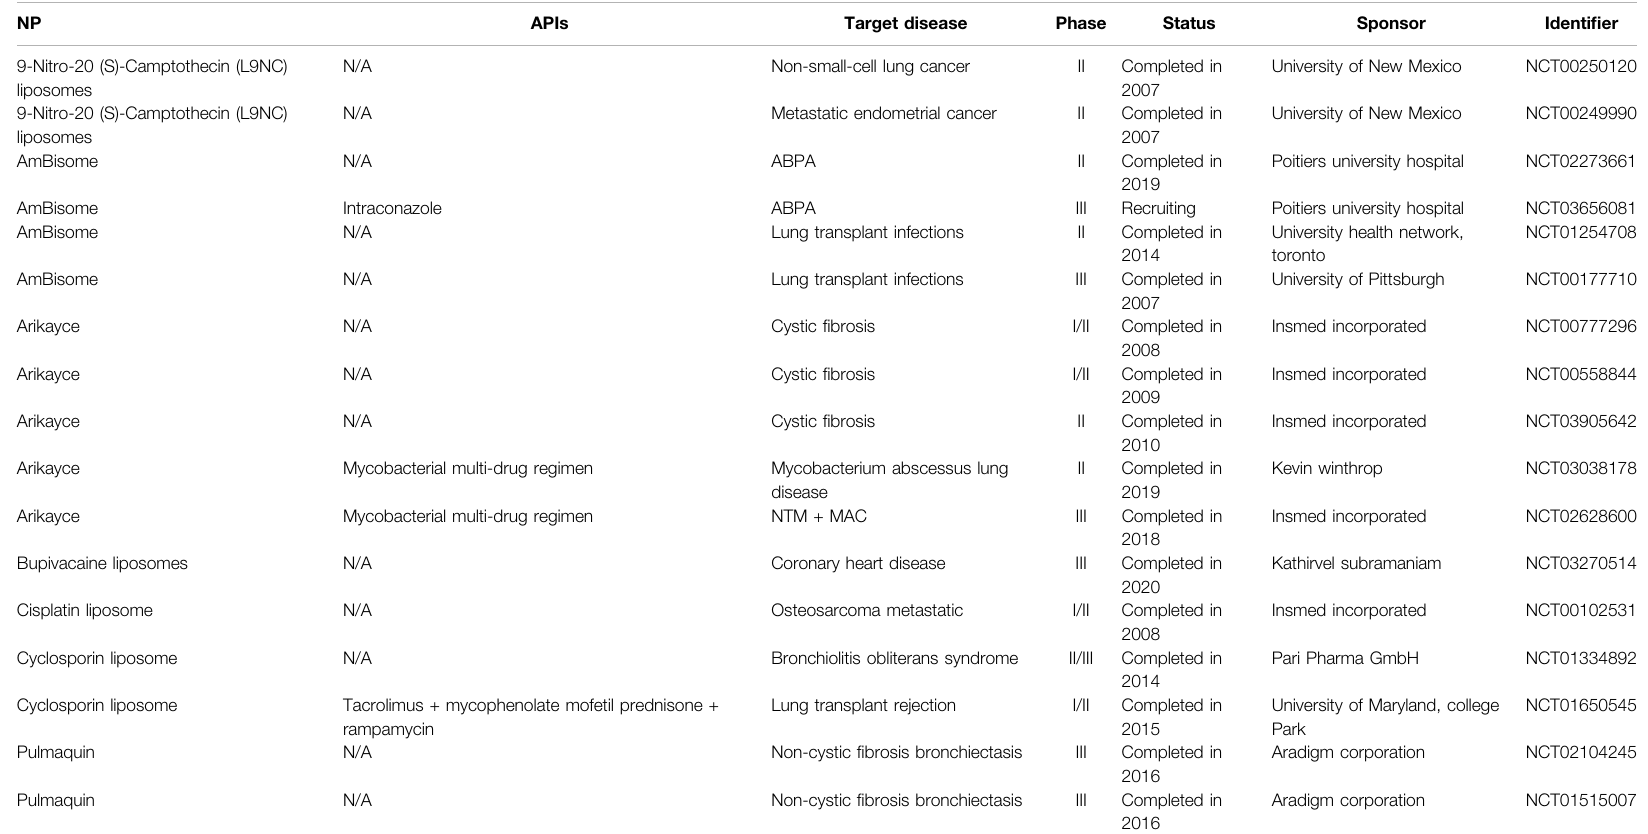
TABLE 2 | A summary of current clinical trials for aerosolized liposomes.